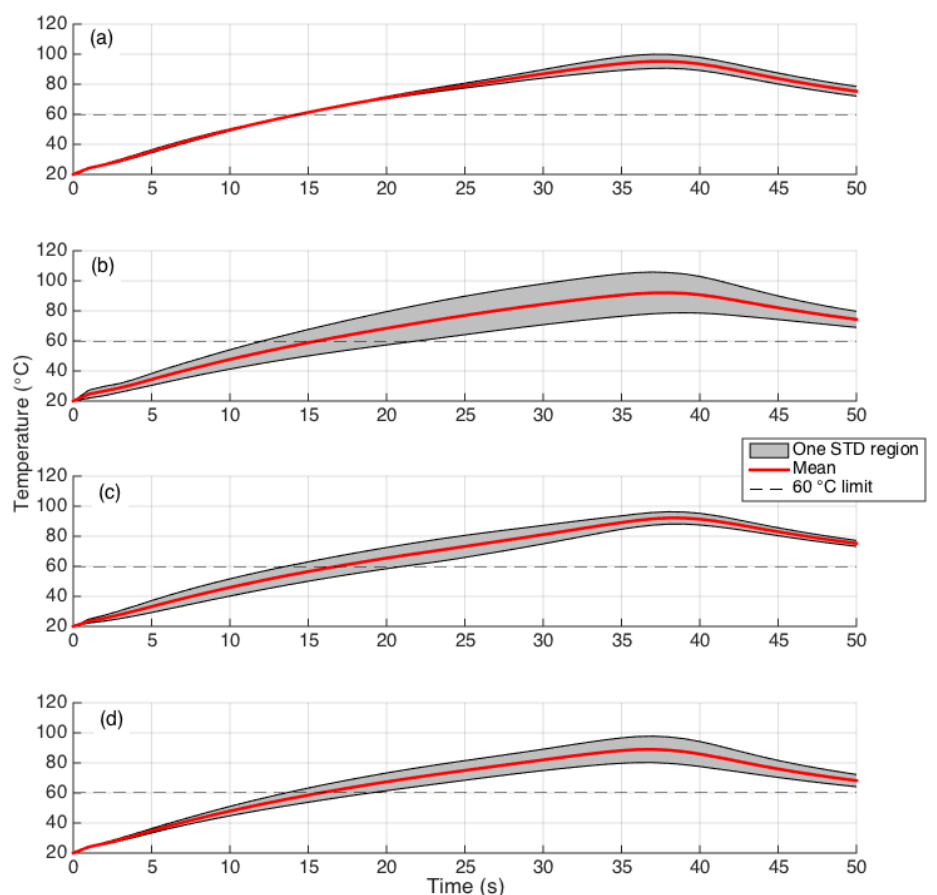
Figure 12. Temporal evolution of the maximum temperature over time, for each RFA ablation. The chart reports the results of four experiments, displaying the mean value (red curve) and the range containing ± one standard deviation (grey interval). RFA conditions: ( a ) agarose; ( b ) AuNP, 1 mg/mL; ( c ) AuNP, 4 mg/mL; ( d ) pristine.